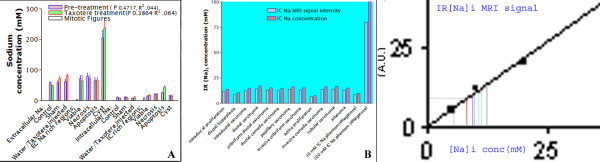
The sodium IR MRI signal intensities and calculated IR sodium concentrations are shown as histograms for pre-malignant tumor features shown in Figure 7. In left panel A, different intracellular sodium MRI signal intensities and concentrations indicated for [intraductal proliferation 11.5(2); ductal hyperplacia 8.8 (3); apoptosis with intraductal carcinoma 12.4* (6,13) and active proliferation 6.2* (2); ductal carcinoma 14.2* (17); cribriform ductal carcinoma 12.8* (7); ductal comedo carcinoma 12.2* (4)]; Malignant features [papillary carcinoma 13.5* (9,11); invasive cribriform carcinoma 12.8* (18); invasive comedo carcinoma 13.5* (22); tubular carcinoma 13.8*; adenoma 12.5* (2,8)]. Tumor different histology features under high power fields are shown in brackets correspond with histology regions in Figure 7. The panel B, in center represents the match of IC sodium concentrations with IC sodium MRI signal intensities. In different tumor regions, IC sodium MRI concentrations were calculated relative to the phantom MRI signal intensities shown as linear curve in Figure 2. In the right panel C, IC sodium concentrations and MRI signal intensities at different tumor premalignant or malignant locations represent the possibility of quick assessment of tumor characterization with possible staging.